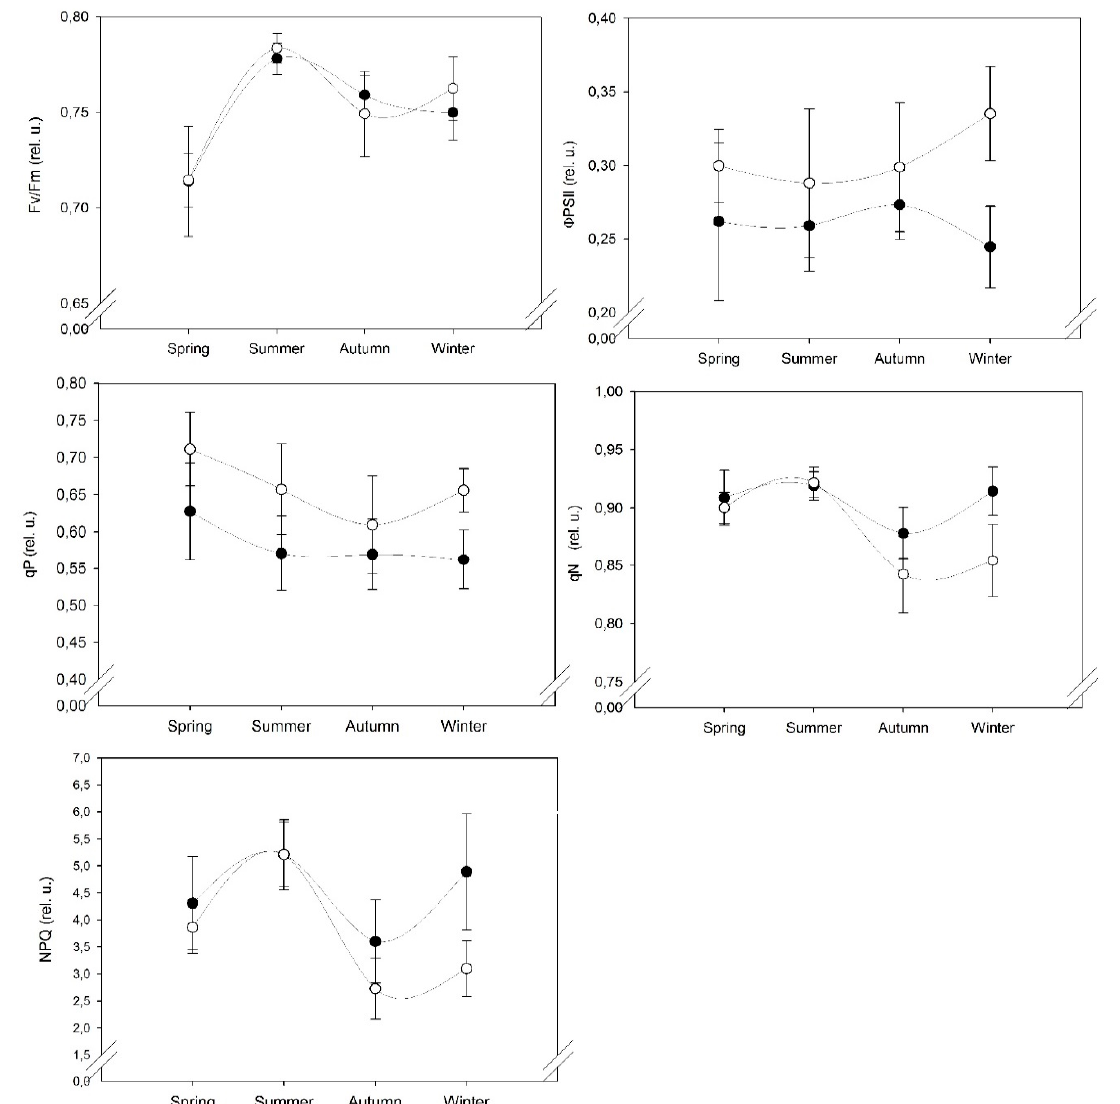
Figure 1. Mean of chlorophyll a fluorescence parameters (Fv/Fm, Φ PS II, qP, qN, NPQ) for S. ruralis were plotted against four seasons (Spring, Summer, Autumn, Winter) in two different microhabitats NE: north-east ( ● ), SW: south-west ( ○ ) slopes. Error bars represent standard error of the mean.